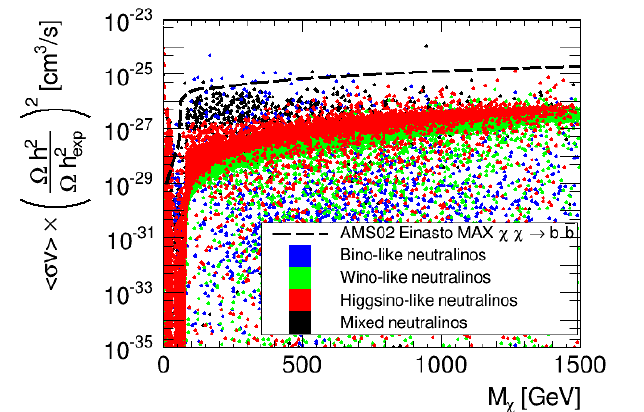
Figure 10 . Points excluded by Fermi-LAT gamma ray and AMS-02 antiproton data in the to- tal annihilation cross section vs. neutralino 1 mass parameter plane, where the total annihilation cross section is rescaled by the relic density. The AMS-02 upper limit with Einasto pro(cid:12)le and Max propagation model for the b (cid:22) b channel is plotted for comparison.